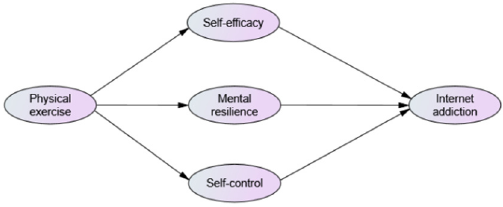
Figure 1. Diagram of the theoretical model of the relationship between physical exercise and Inter- net addiction.